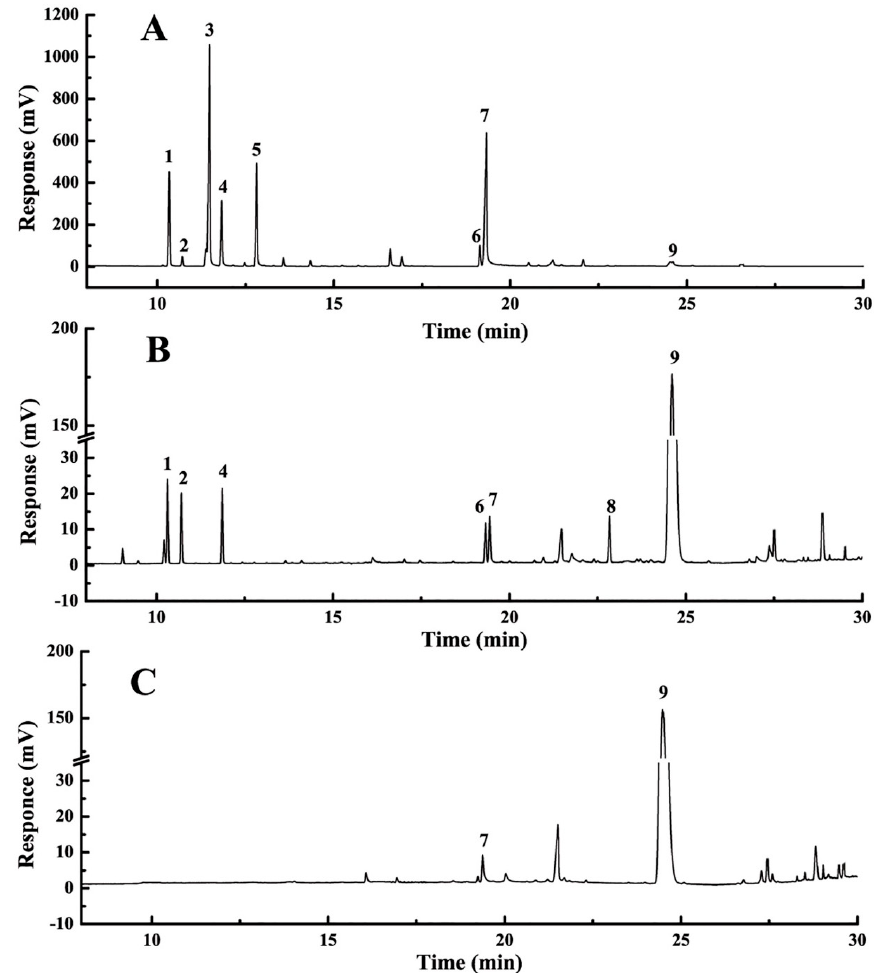
Figure 4. GC chromatograms of HEHEO ( A ); crude HEO ( B ); and pure HEO ( C ). Arabic numerals (1–9) marked in Figure 4 correspond to the compounds listed in Table 3.